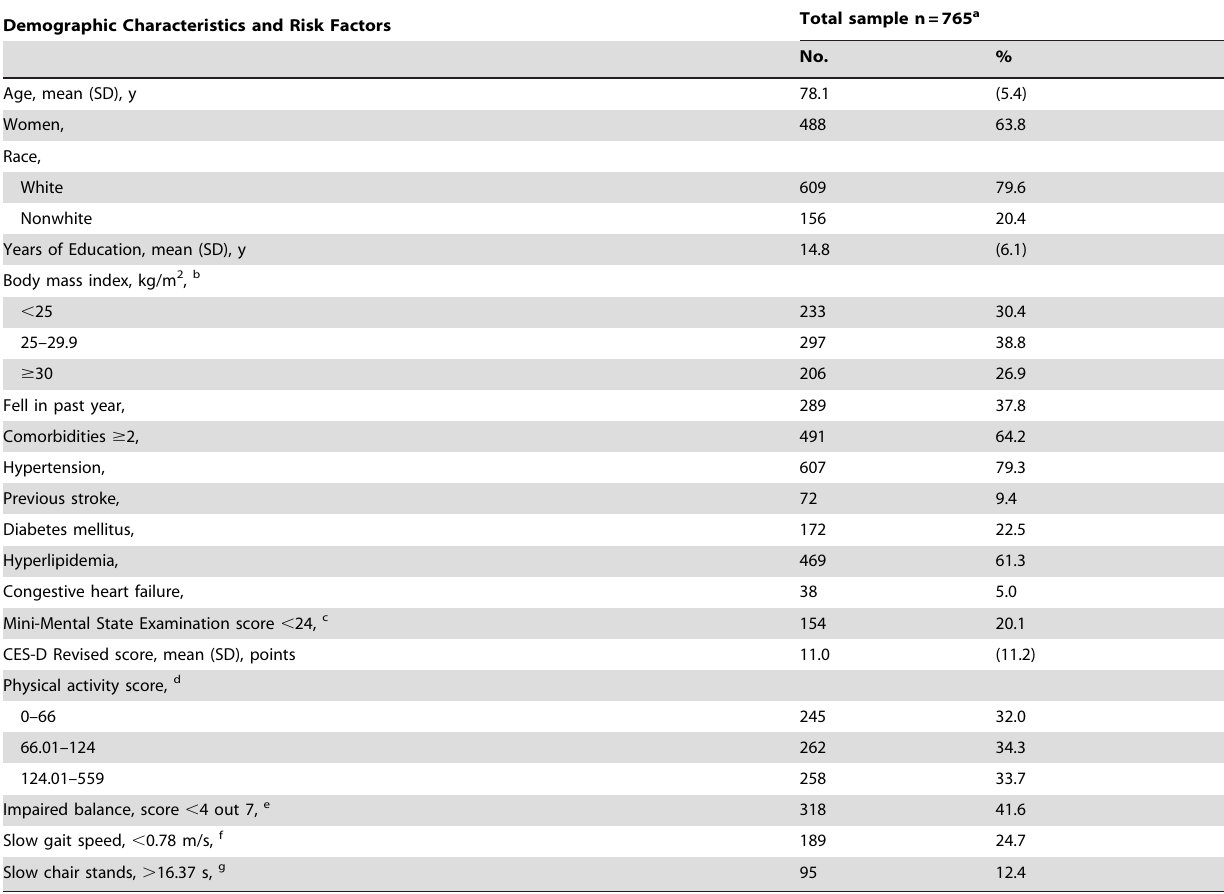
Table 1. Summary of Baseline Characteristics (The MOBILIZE Boston